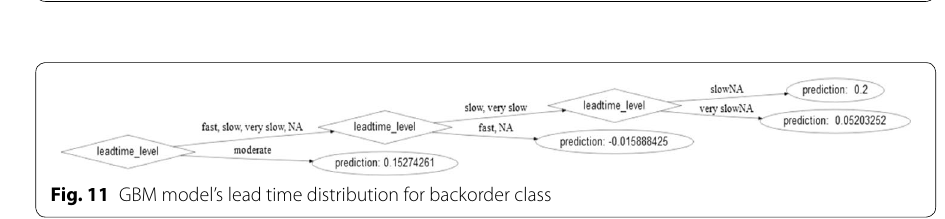
Fig. 10 GBM model’s inventory level distribution for backorder class